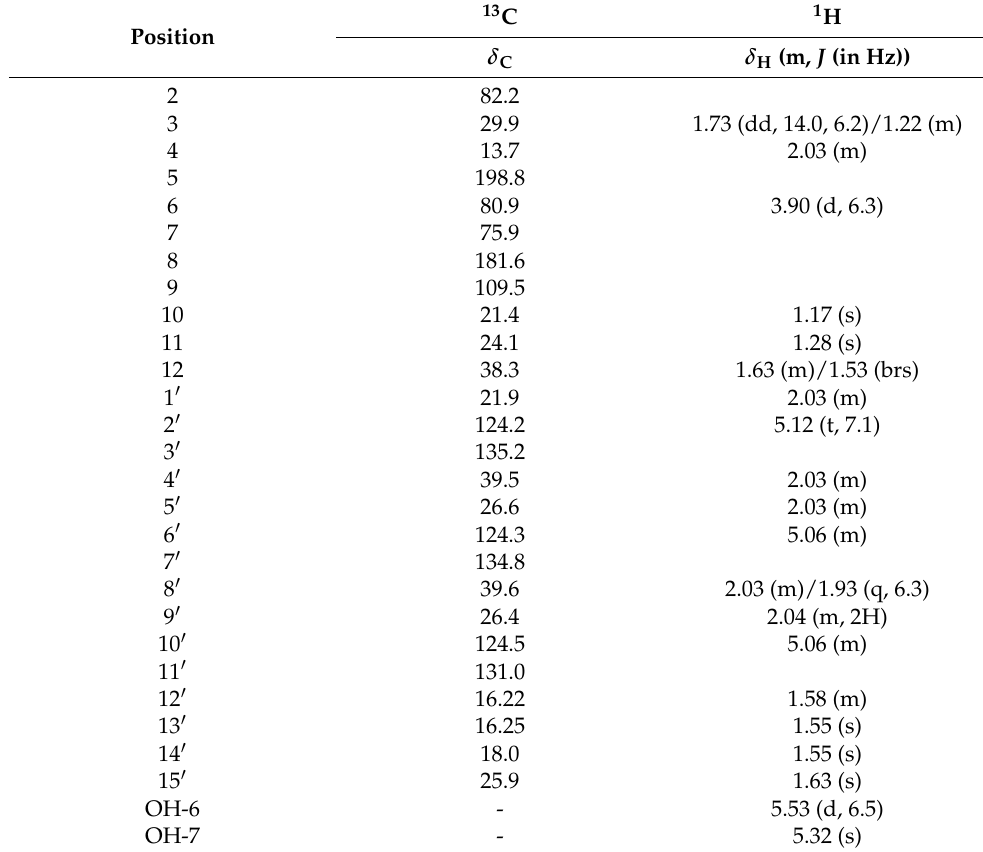
Table 2. 1 H (600 MHz) and 13 C (150 MHz) NMR data of compound 4 in DMSO- d 6 ( δ in